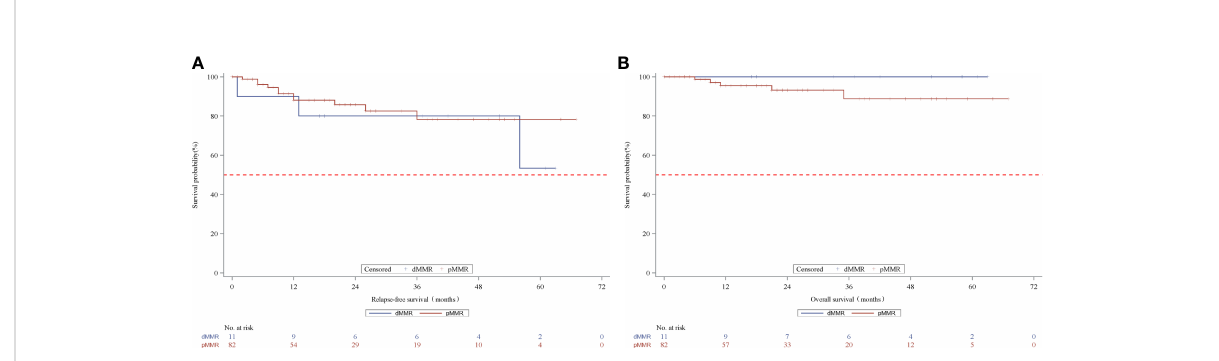
FIGURE 3 Kaplan-Meier curves for recurrence-free survival (A) and overall survival (B) according to MMR status in the TRG downstage subset patients. MMR denotes mismatch repair, dMMRdefective MMR; pMMRpro fi cientMMR; TRG, tumor regression